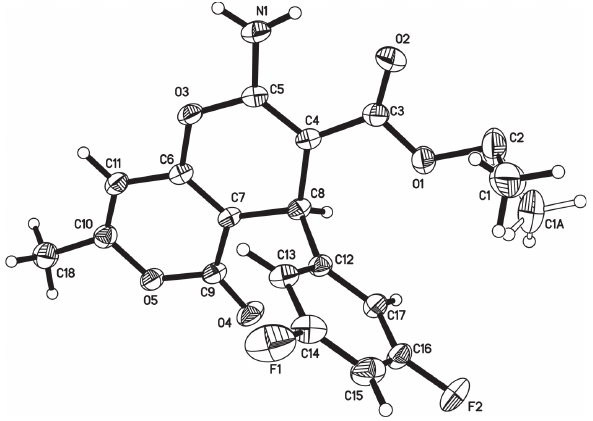
Table 2: Fractional atomic coordinates and isotropic or equivalent isotropic displacement parameters (Å 2